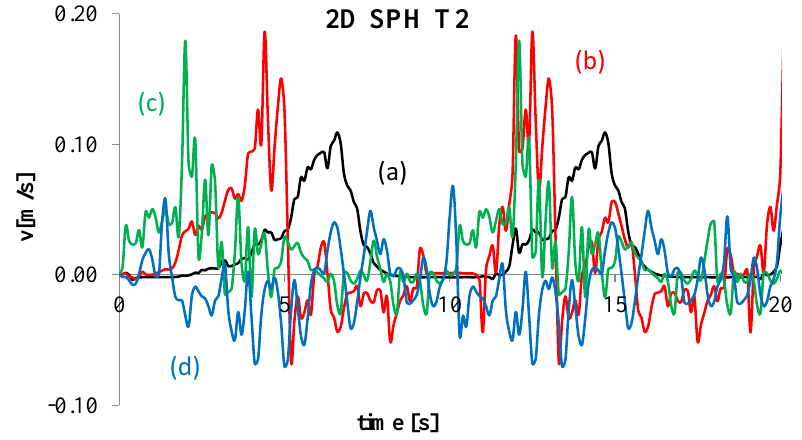
Figure 22. Time series of the horizontal velocity component under hydraulic jump (configuration: T2) measured at a distance of: ( a ) 7 cm; ( b ) 10 cm; ( c ) 20 cm; and ( d ) 100 cm, from the time-averaged position of the hydraulic jump toe.